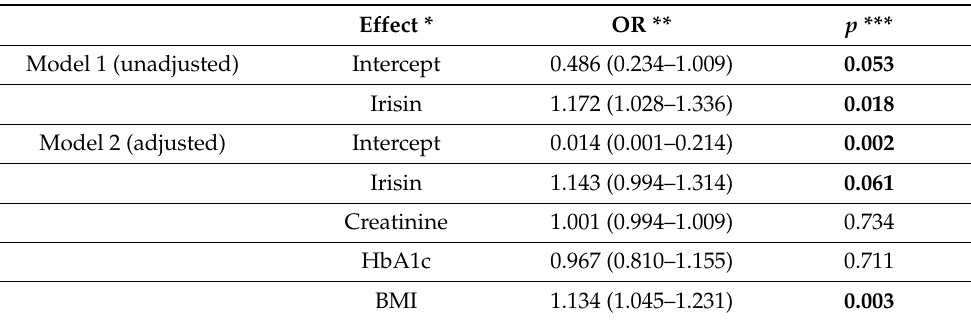
Table 5. Logistic regression models for NAFLD risk in relation to irisin concentration. Model 1 refers to univariate irisin-NAFLD dependency and model 2 refers to irisin-NAFLD relationship adjusted for variables strongly correlated with irisin concentration. Effect * OR ** p *** Model 1 (unadjusted) Intercept 0.486 (0.234–1.009) 0.053